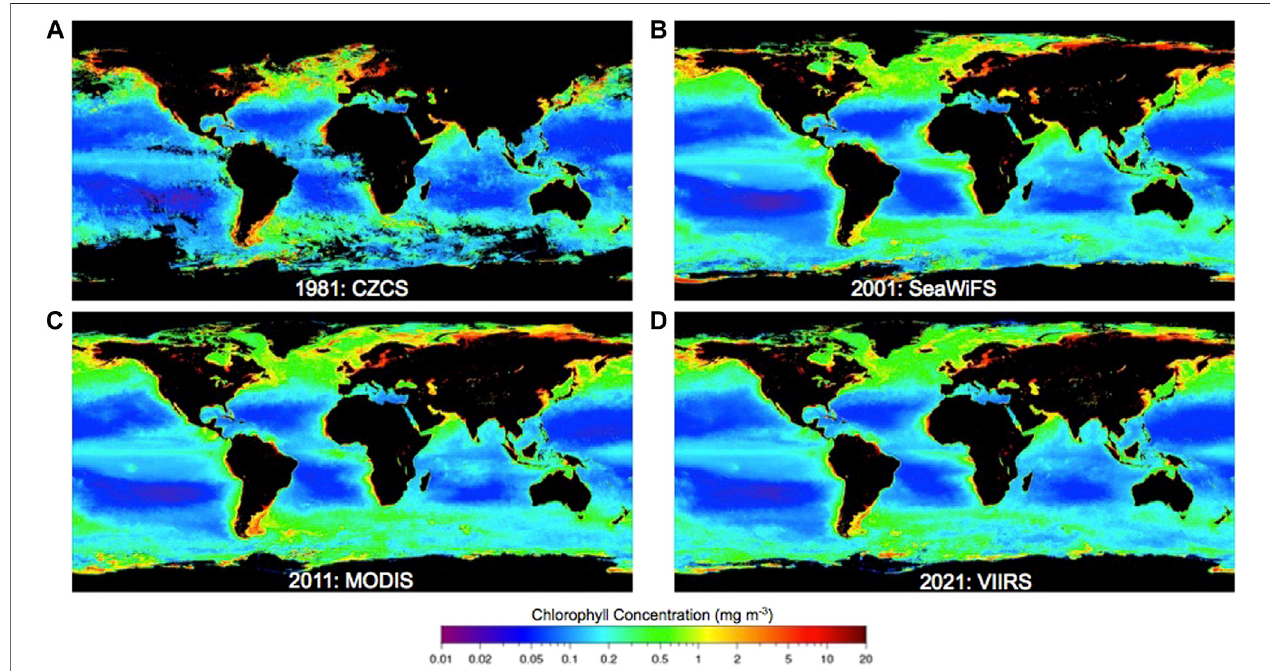
FIGURE 1 | Global annual average chla composites derived from CZCS, SeaWiFS, MODIS, and VIIRS sensors for years 1981 (A) , 2001 (B) , 2011 (C) , and 2021 (D) , respectively.